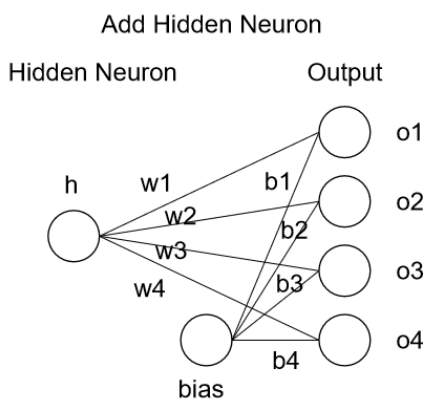
Figure 3. The hidden unit provides suitable features to the network.